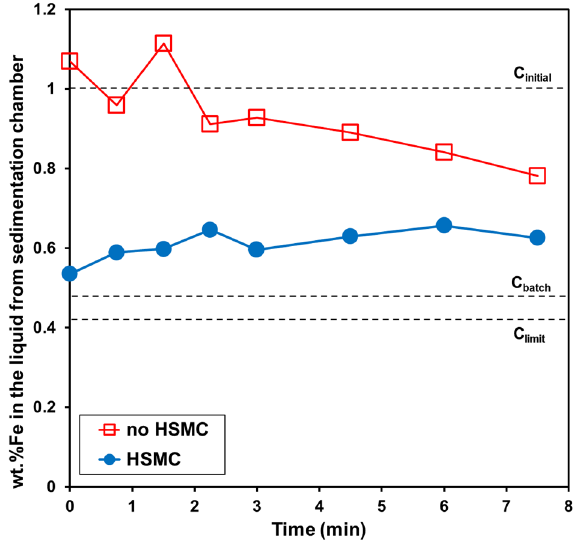
Figure 11. Level of Fe (wt.%) in the molten alloy collected from the sedimentation chamber as the molten metal starts to flow out (t = 0) from the sedimentation chamber at a continuous melt flow rate of 250 Kg/h.